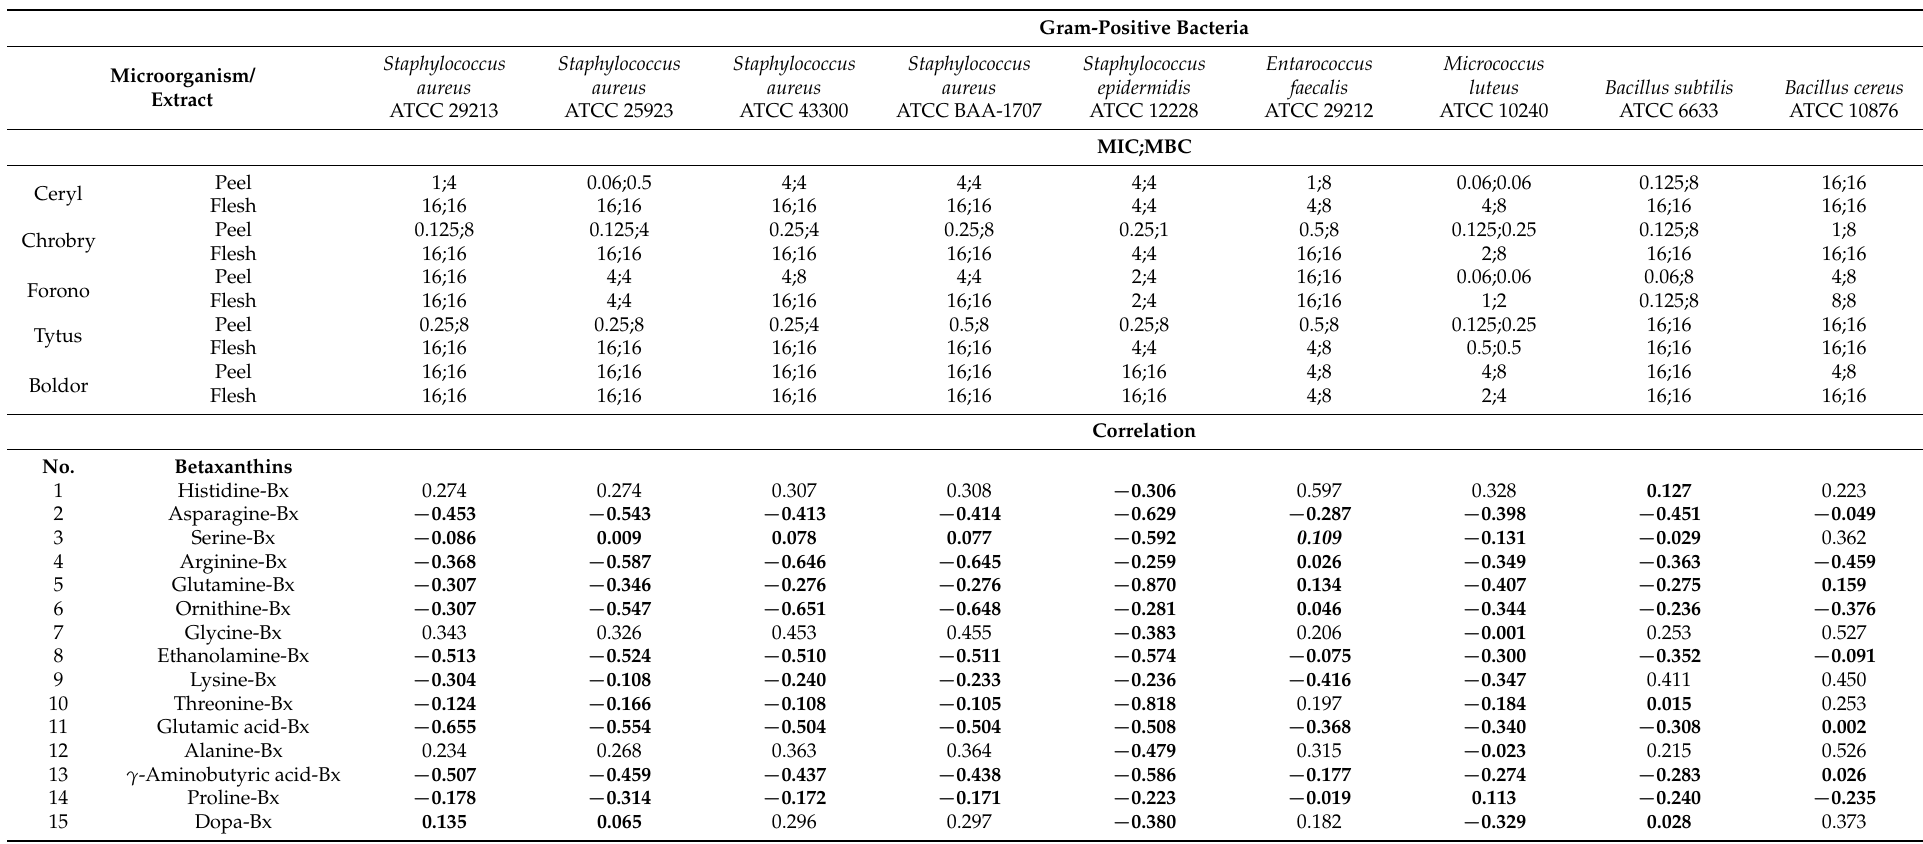
Table 4. Antimicrobial activity of extracts obtained from red and yellow B. vulgaris cultivars assessed as MIC (minimum inhibitory concentration) and MBC (minimum bactericidal concentration) against strains of Gram-positive bacteria and correlation coefficients between identified betaxanthins (absolute peak areas) and microbial activity (MIC values). Statistical significance is marked by font: boldface means 95% significance, normal font lack of significance at